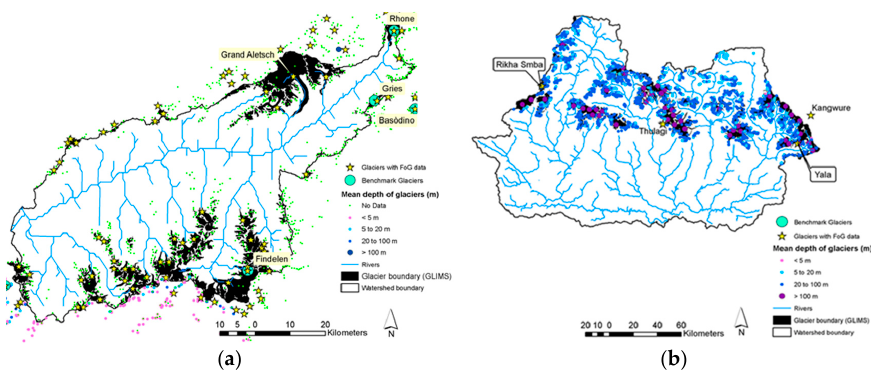
Figure A1. Glacier snow depth and area across the ( a ) Rhone and ( b ) Narayani river basins extracted from the GLIMS glacier outlines. Green dots show locations of glaciers with no depth information.